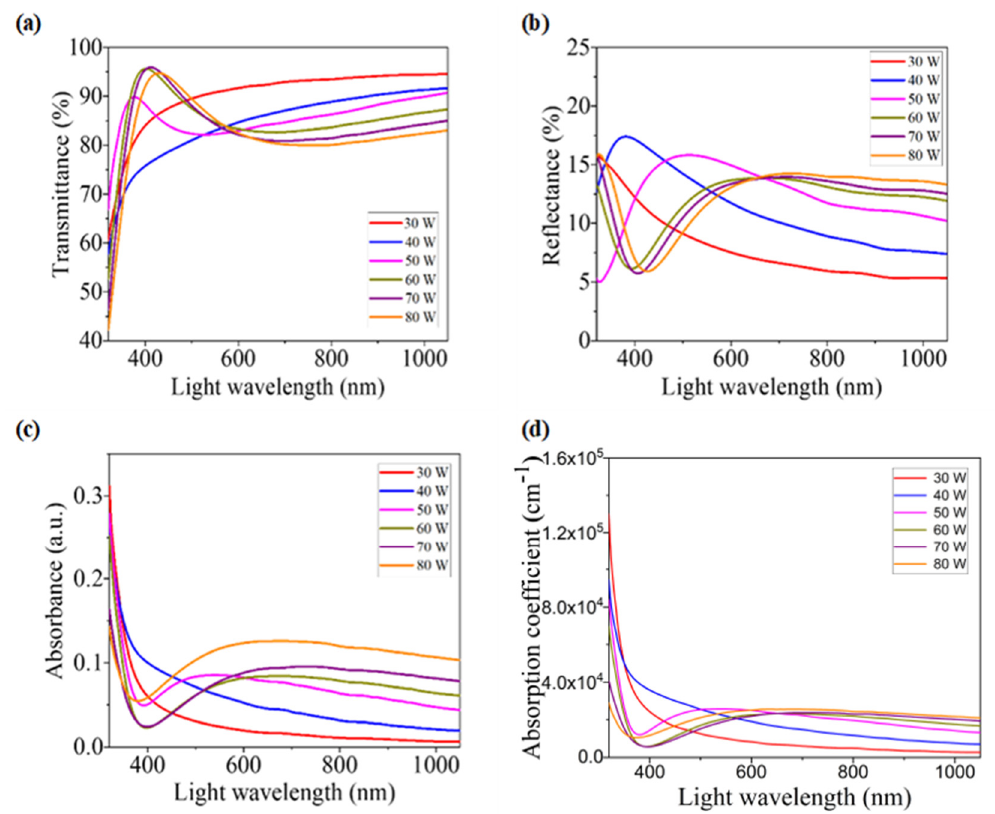
Figure 4. ( a ) Transmittance, ( b ) reflectance, ( c ) absorbance, and ( d ) absorption coefficient spectra for WO x films developed at various RF sputtering powers.